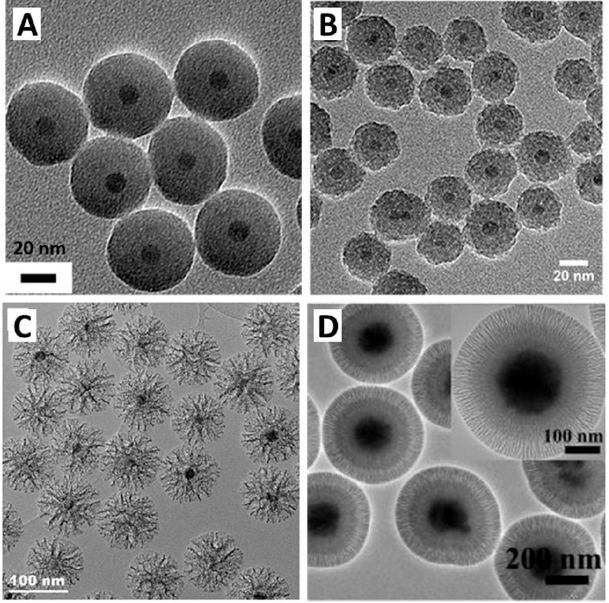
Figure 2. TEM images of iron oxide core@silica shell NPs from the literature with di ff erent morphol- ogies of the silica obtained by di ff erent synthetic pathways. Non-porous silica ( A ) [16], mesoporous silica with small pores (around 2.5 nm) ( B ) [17], mesoporous silica with larger pores (about 10 nm) ( C ) [18], and a silica shell made of two layers with an interior non-porous silica coating, above which sits a mesoporous silica shell with radially-oriented large pores (10 nm) ( D ) [19]. Reprinted (adapted) with permissions from Refs. [16–19].